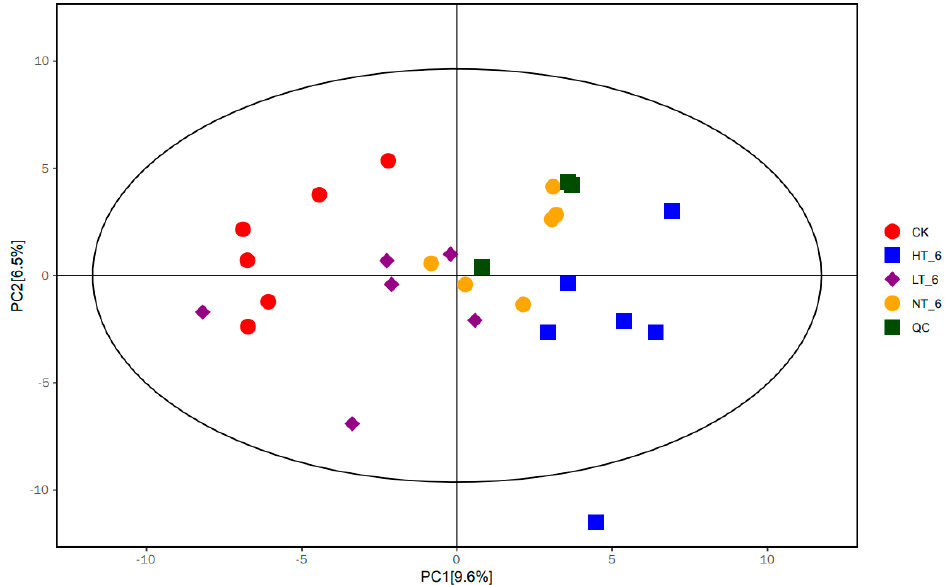
Figure 3. Scatter plot from PCA model for CK_6, LT_6, NT_6, HT_6, and QC groups. The abscissa PC[1] and ordinate PC[2] in the figure represent the scores of the first and second principal compo- nents, respectively. Each scatter represents a sample, and the color and shape of the scatter represent different groups. The samples were basically within the 95% confidence interval, and the QC group was tightly gathered and close to the middle of all samples, suggesting great system stability within the entire measurement queue. R 2 X represents the model’s interpretation of the X variable and Q 2 represents the predictability of the model. The closer the two metrics are to 1, the better the model performs and the higher the